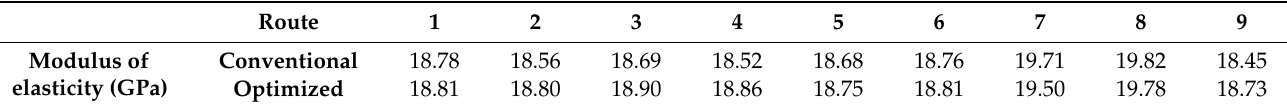
Table 5. Modulus of elasticity of porous